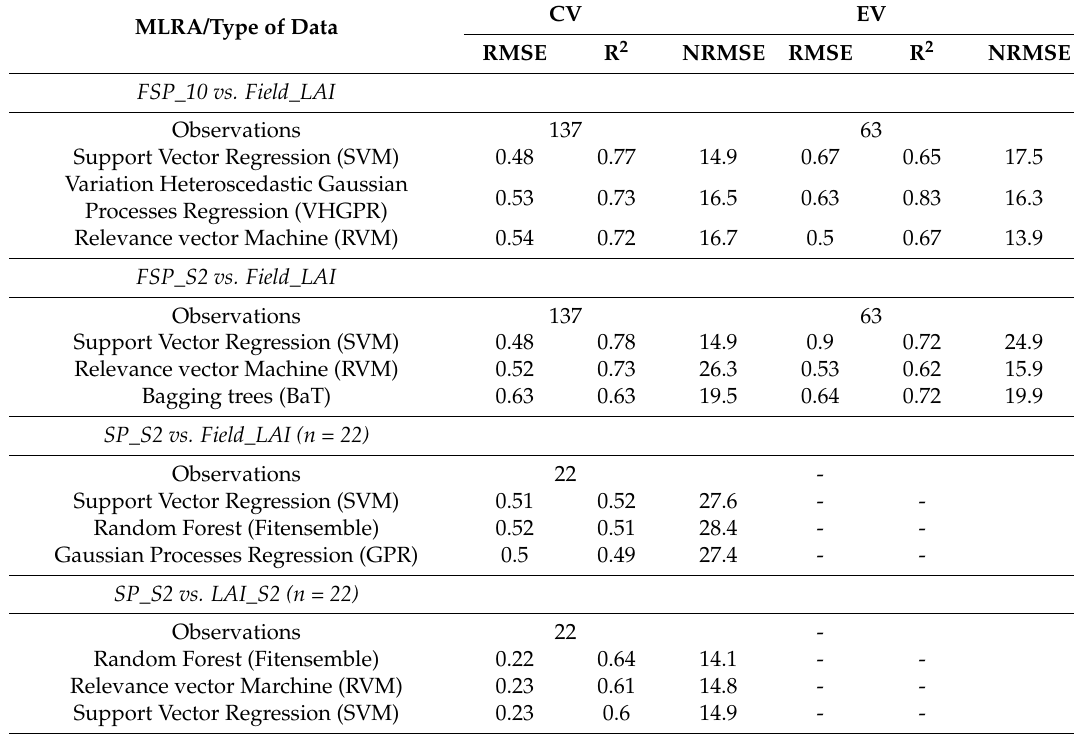
Table 7. Goodness-of-fit statistics for the LAI models of the best performing machine learning regression algorithms (MLRA) applied to different combinations of spectral and leaf area